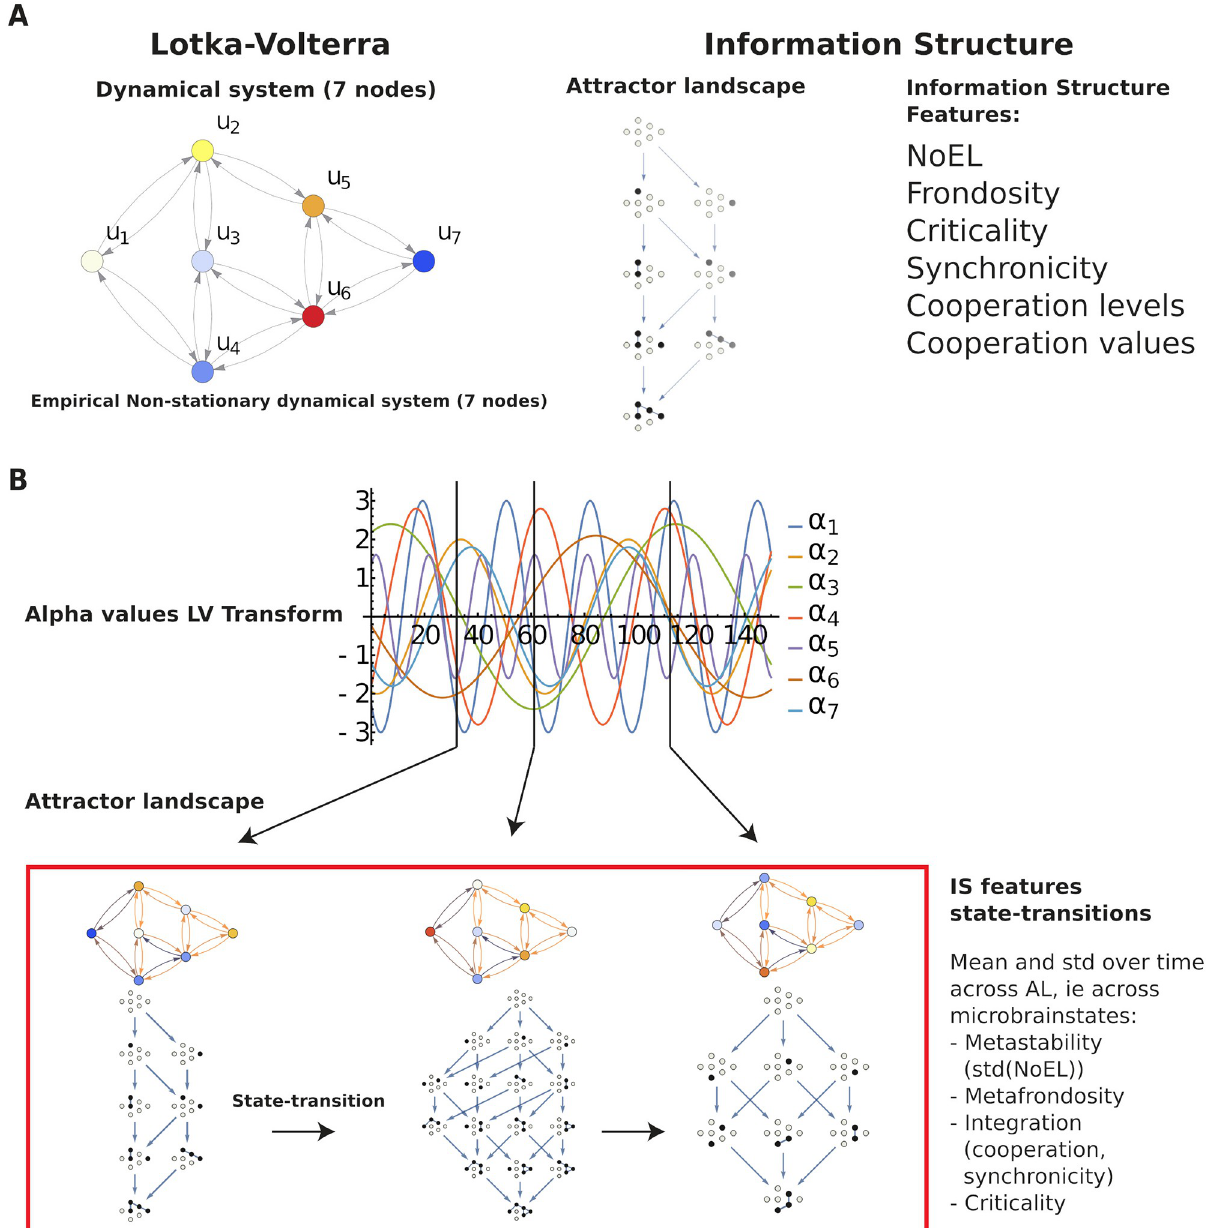
Fig 1. Information structures and their dynamics. A . Left: Lotka-Volterra 7-node dynamical system. Relevant parameters are those affecting just one ) and those representing interactions, given by the weighted links ( γ ) between nodes ( i and j ). Right: Associated to each system (for given α node ( α i ij i and γ ij parameters) there is an Information Structure (IS), containing the attractor landscape, that is, stationary points of the system dynamics and the solutions linking them. Black nodes in the stationary points represent a value greater than 0 of the corresponding node of the dynamical system. White nodes stand for 0 value of the corresponding node. Different γ and α values produce different IS in both the globally asymptotically stable solution ij i (GASS, in the bottom) and the nodes in the intermediate levels. The structure of the IS can be studied through several measures (see Fig 2) depending not only on the number of levels and nodes (NoEL and Frondosity, respectively) but also on the interaction between nodes (Synchronicity, Criticality and Cooperation measures). B . For a dynamical system with fixed connectivity ( γ ij parameters) and changing activity among the nodes ( α i ) it is possible to study the evolution of the IS measures. The top graphic represents the change in time of the α parameters in a Lotka-Volterra 7-node system with i fixed connectivity γ ij . Associated to each instant there is an IS with the structure of the attractor underlying the dynamics of the system. The evolution of the system dynamics can be characterised by looking at the mean and standard deviation across time of the IS measures.